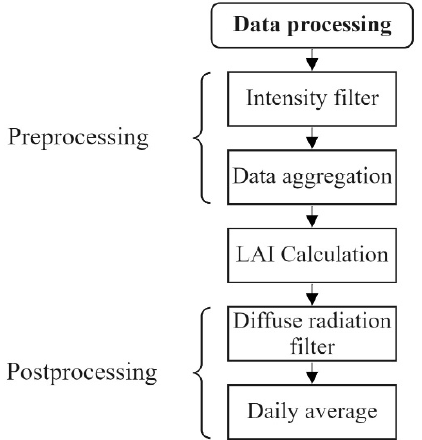
Figure 5. Overview of the developed data processing that was applied on the measurement data of